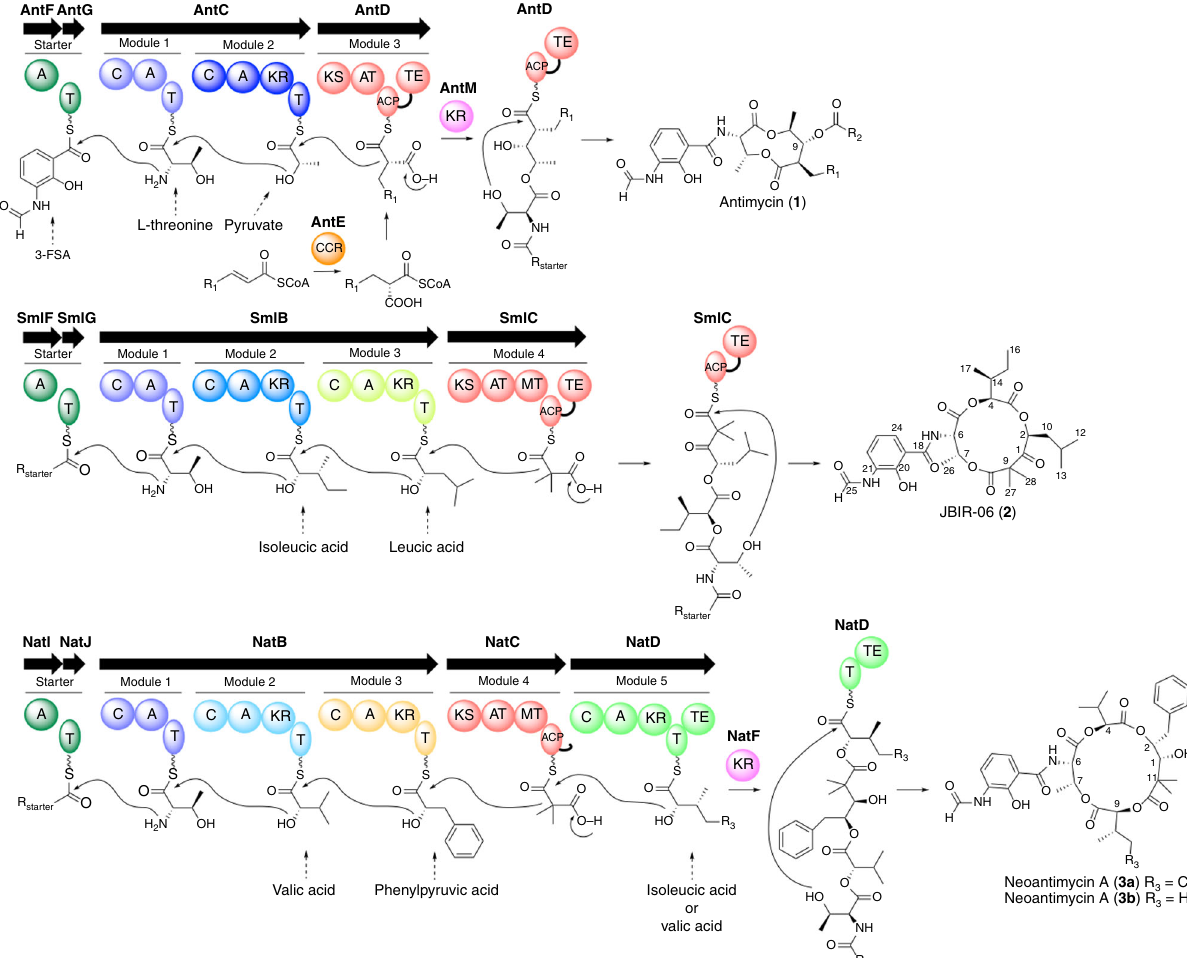
Fig. 1 Organization of modular enzymes involved in the biosynthesis of antimycin-type depsipeptides. C condensation, A adenylation, T thiolation, KR ketoreductase, KS ketosynthase, AT acyltransferase, ACP acyl carrier protein, MT methyltransferase, TE thioesterase, CCR crotonyl-CoA reductase/ carboxylase, R 1 and R 2 various alkyl groups, R starter the acyl moiety of 3-FSA. The module and domain organizations of the starter, the module 1, and the module 2 are identical among the all three systems. The starter and the module 1 uptake 3-FSA and L-threonine, respectively, common to all pathways, but the module 2 uptake pyruvate (AntC), isoleucic acid (SmlB), and valic acid (NatB), respectively. JBIR-06 and neoantimycin systems include an additional NRPS modules (module 3) after the module 2 in the same ORF. The module 3 in SmlB uptakes phenylpyruvic acid, and the module 3 in NatB uptakes leucic acid. The PKS modules of JBIR-06 and neoantimycin systems (module 4) contain MT domain between AT and ACP, and accept malonyl-CoA as an extender unit, to yield dimethyl group at the α -position of polyketide moiety, differently from antimycin system. Furthermore, neoantimycin system includes an extra NRPS module (module 5 as NatD) which uptakes isoleucic acid or valic